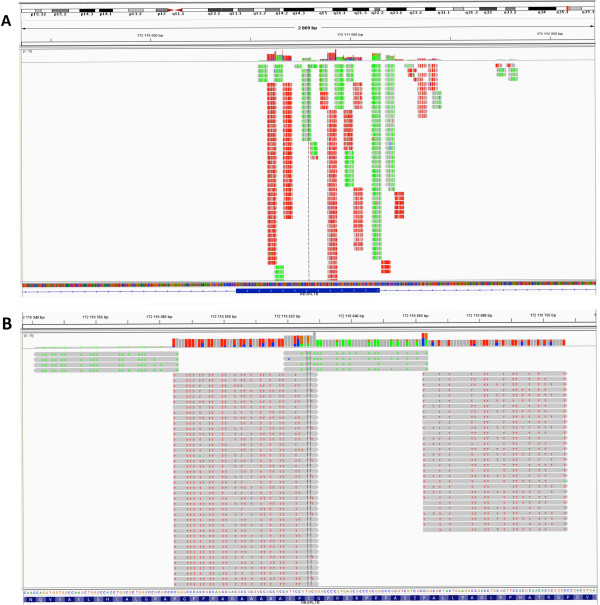
Use of the Integrated Genome Viewer (IGV) showing an example of data at one locus in one subject. A) IGV view of a 45 kb window on chromosome 5. Reads should map to distinct regions (due to MspI digestion), and there should be an equivalent balance of forward and reverse reads. Gray shading represents perfect alignment with the HG19 standard human reference genome. B) Close-up of the region from A) showing that forward reads have a high proportion of red ‘T’s and reverse reads have a high proportion of green ‘A’s; IGV shows colored bases in gray reads when an error is detected. In this case, the read is perfectly aligned to the standard reference genome, but, due to bisulfite conversion, most ‘C’s have converted to ‘T’s (forward strand), and this is outputted in the IGV window. Diversity at a locus is partially generated by different methylation levels at specific CpG sites and sequencing errors.